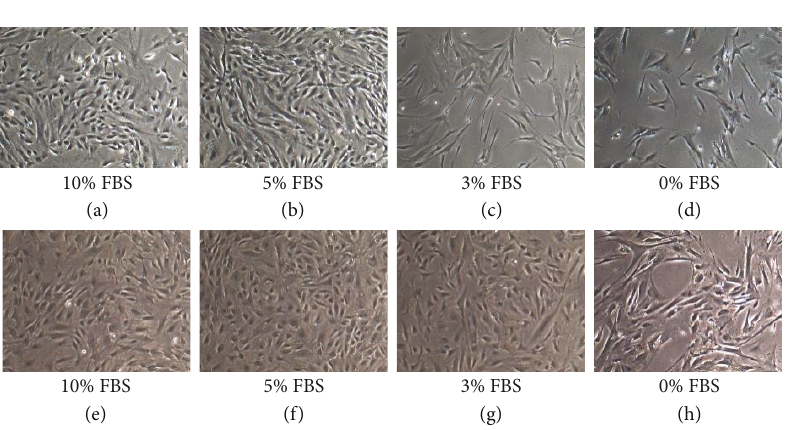
Figure 1: (a, b, c, d) Human cardiac biopsy-derived stem cells cultured in sequentially optimized serum-free culture medium on recombinant human fi bronectin-coated surface. (e, f, g, h) Control culture of human cardiac biopsy-derived stem cells in commercially available serum-free proprietary medium (Essential 6 ™ , Gibco) on fi bronectin-coated surface. Authors ’ unpublished